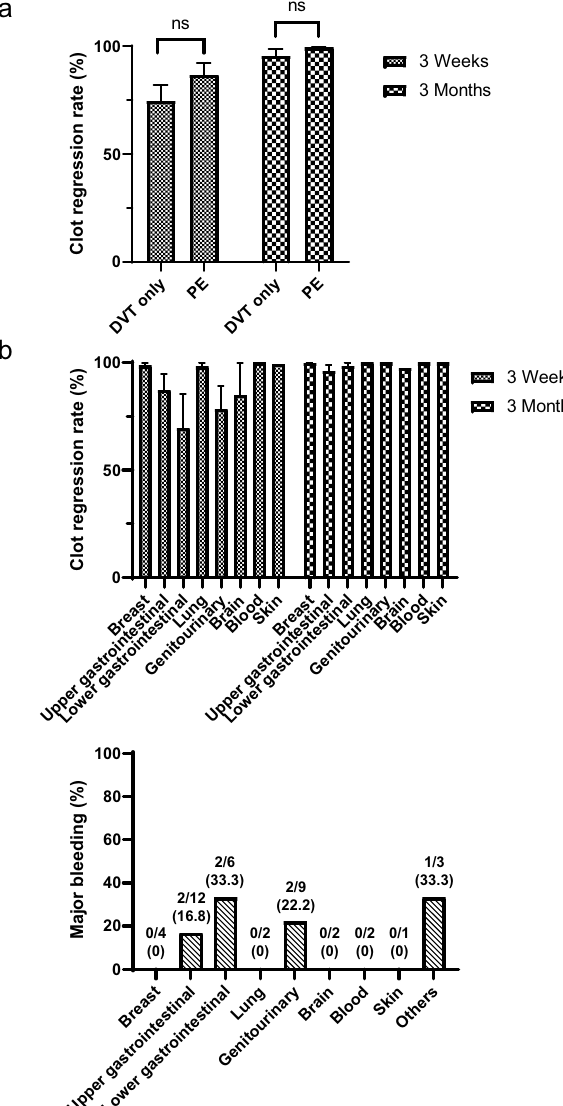
Figure 4. Clot-regression rate and major bleeding according to the PE involvement and cancer type. ( a ) Clot- regression rate between DVT-only patients and PE patients. ( b ) Clot-regression rate and major bleeding based on the cancer type. Data are expressed as mean ± standard error or percentage. ns, not significant; DVT, deep vein thrombosis; PE, pulmonary